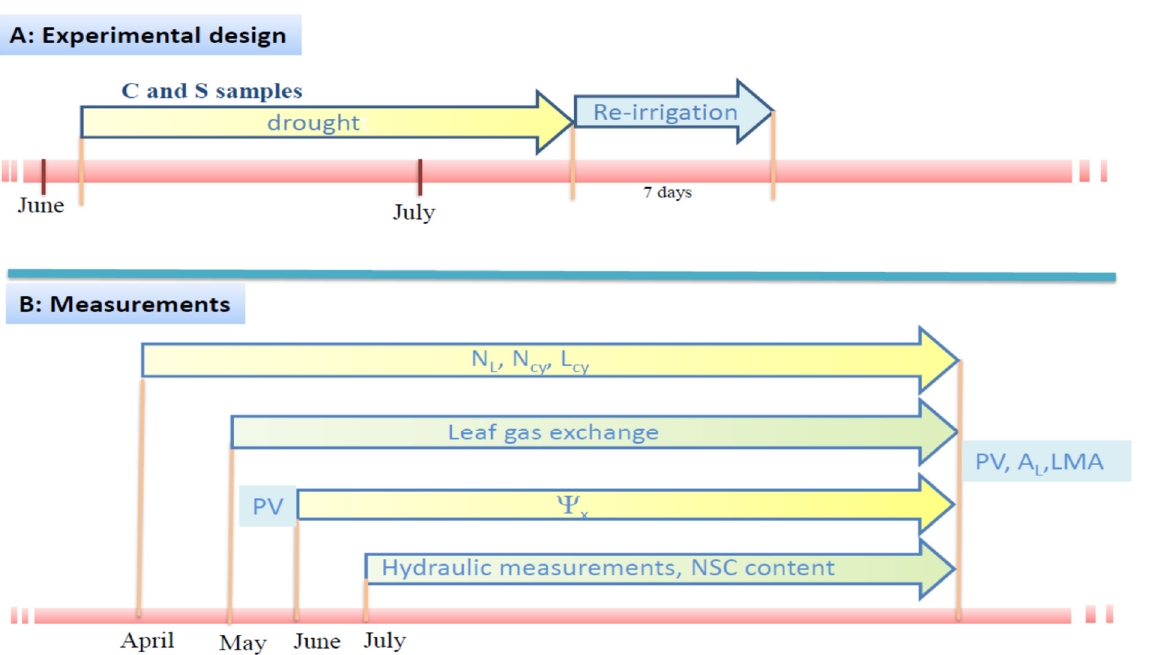
Figure 1. ( A ) Experimental design and ( B ) measurements performed on control and stem-shaded samples (C and S, respectively) of L. nobilis and P. alba plants; ( A ) At the beginning of June, C and S samples were subjected to a water stress treatment. One month later, a set of samples was measured for different physiological parameters. Another set of plants was re-irrigated at field capacity and measured after 7 days to evaluate the capacity for recovery; ( B ) Leaf gas exchange rates were measured from May to the end of the experiment; xylem water potential ( Ψ x ) values were recorded from June to the end of experiments; hydraulic measurements and NSC content were performed after the drought treatment and 7 days after re-irrigation. Moreover, PV-curves were measured before and at the end of the drought-recovery treatments. Leaf area and leaf mass per area were measured at the end of the experiments (for details, see the text). PV: pressure volume curves; N L : number of leaves of the current-year branches; N cy : number of current-year branches; L cy : length of the current-year branches; A L : leaf area; LMA: leaf mass area.